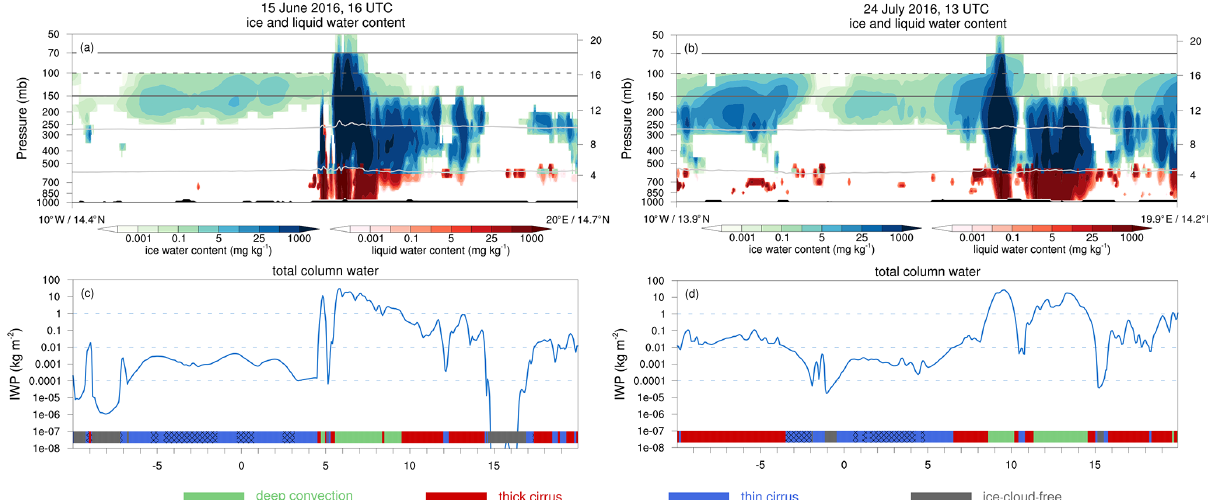
Figure 12. Illustrative examples of the different ice cloud regimes. Panels (a) and (b) show the vertical cross sections in a zonal direction with ice water content in blue (mgkg − 1 ) and liquid water content in red (mgkg − 1 ) for 15 June 2016 at 16:00UTC and 15 June 2016 at 16:00UTC respectively; panels (c) and (d) show the corresponding IWP amounts (blue, kgm − 2 ) for the same respective dates and times. The horizontal lines in panels (c) and (d) indicate the thresholds applied to IWP (light blue) to distinguish the different ice cloud regimes. The coloured bars in the lower parts of panels (c) and (d) detail the ice cloud regimes as indicated by the legend below, and the black hatching of the blue bars indicates thin-cirrus regions where TQI > TQS; see the text for